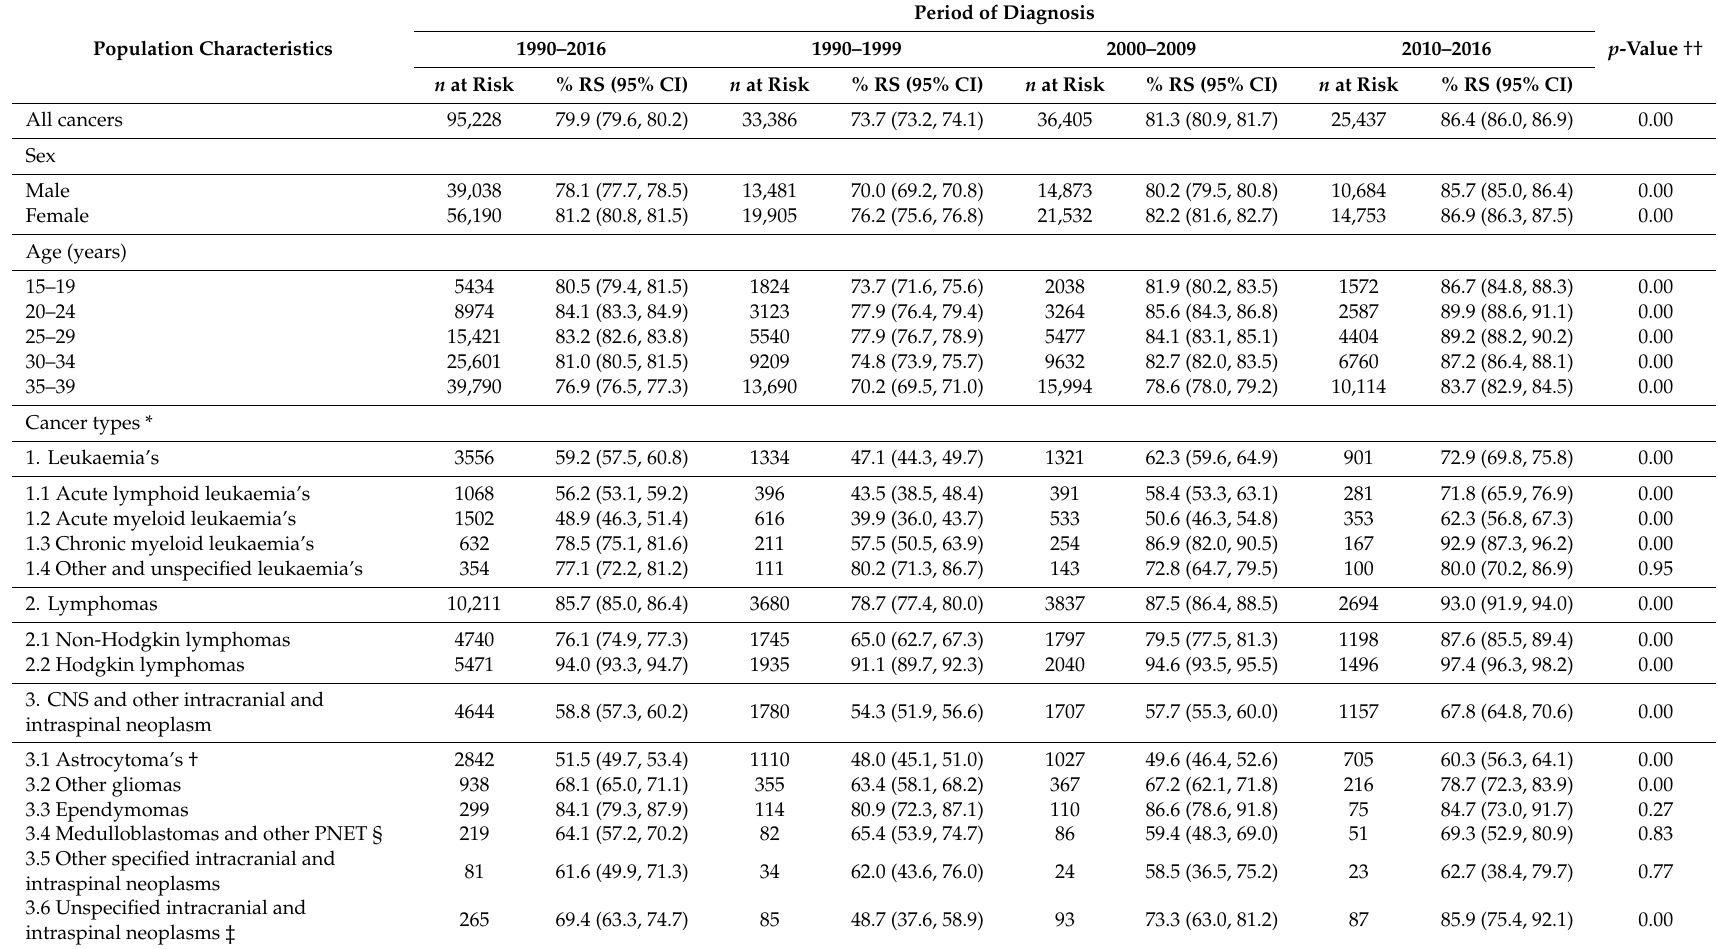
Table 2. Number at risk and five-year relative survival estimates with 95% confidence intervals of adolescent and young adult (AYA) cancer patients aged 15–39 years at time of diagnosis in the Netherlands between 1990–2016 and presented by sex, age, cancer type and period of